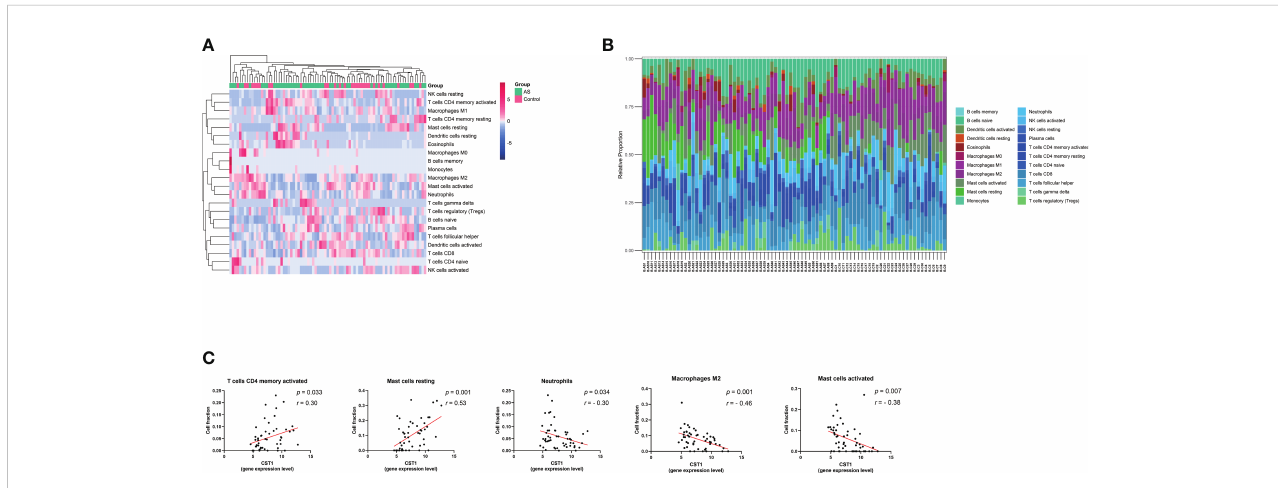
FIGURE 6 Immune in fi ltration analysis. (A) Clustering heatmap of 22 immune cells. The bar legend in the upper right corner represents the relative fold change in cell abundance, with red for increases and green for decreases. Bar legends above represents sample clusters, with AS in green and controls in pink. (B) Histograms show the relative proportion of each immune cell in each sample. Each column represents a sample, and each color represents a cell type. (C) Correlation analysis and scatter plot of CST1 expression level and 5 immune cell fractions in the bronchial epithelium of asthma patients. AS,